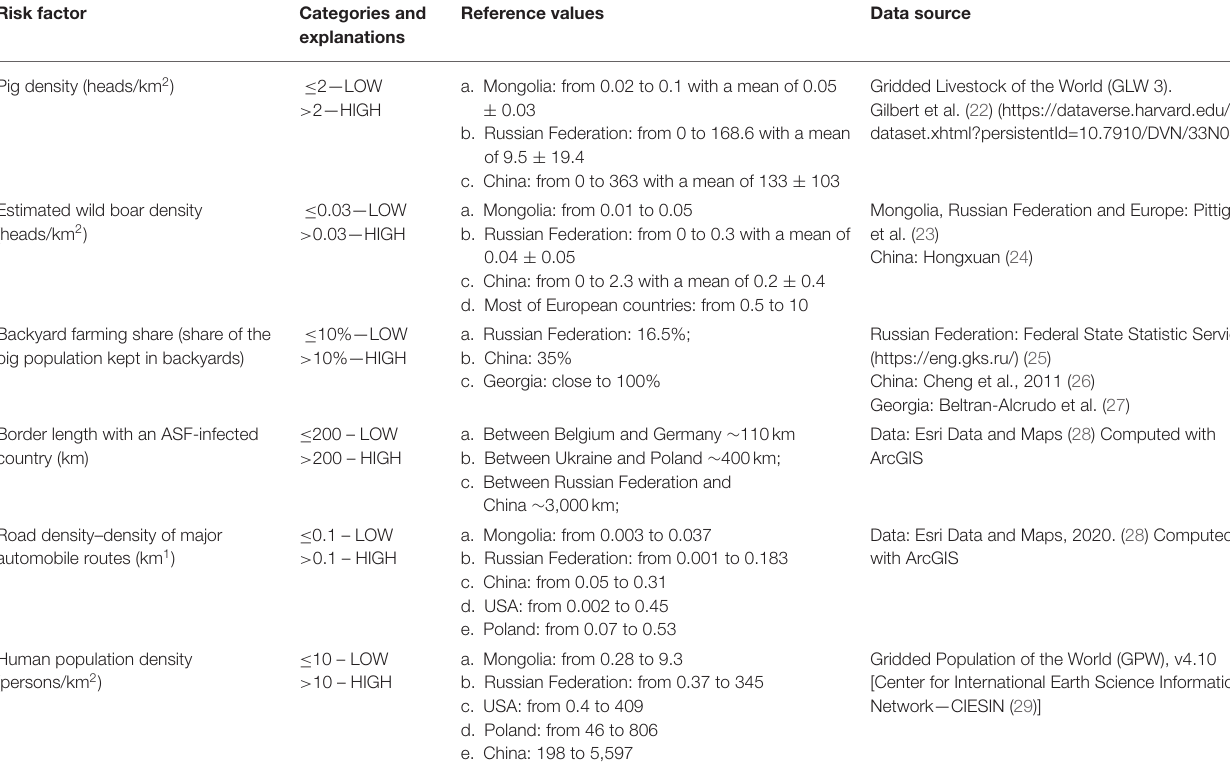
TABLE 2 | Epidemiological factors hypothesized to influence the risk for African swine fever (ASF) were categorized as dichotomous variables considering the values observed in selected countries and regions.